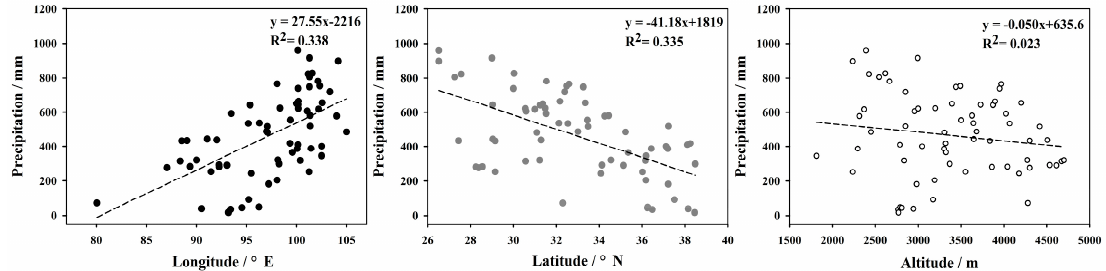
Figure 6. The relationship between precipitation and longitude, latitude and altitude.